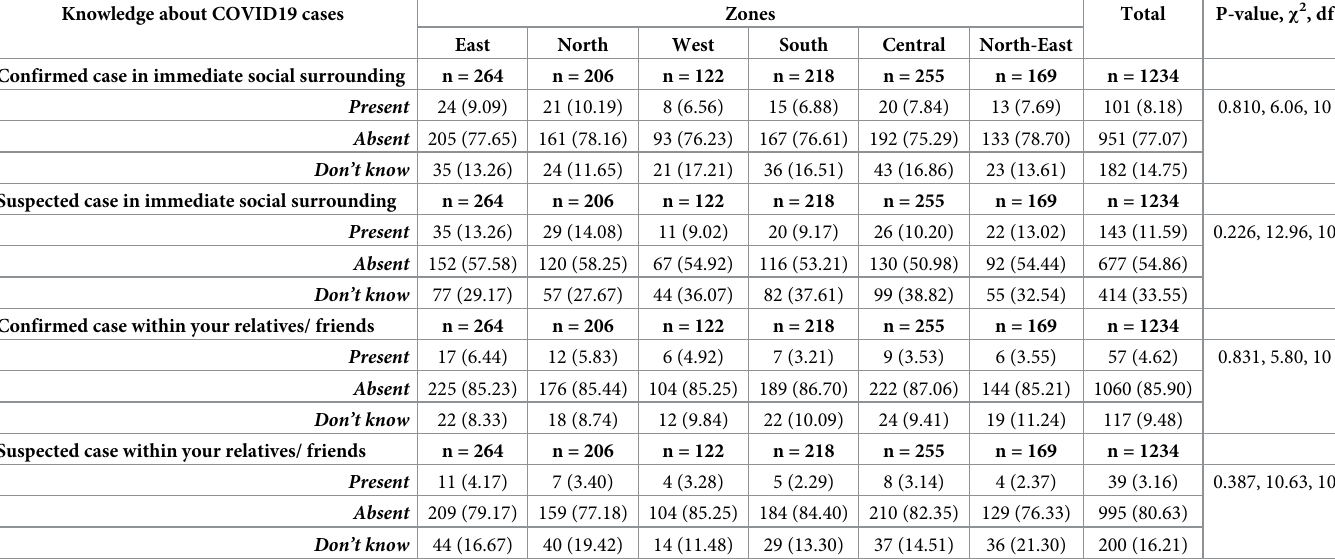
Numbers in the parentheses represent percentage values of the response categories within each zone/overall. χ 2 : Chi-square value for the test of trend within different zones, df: degrees of